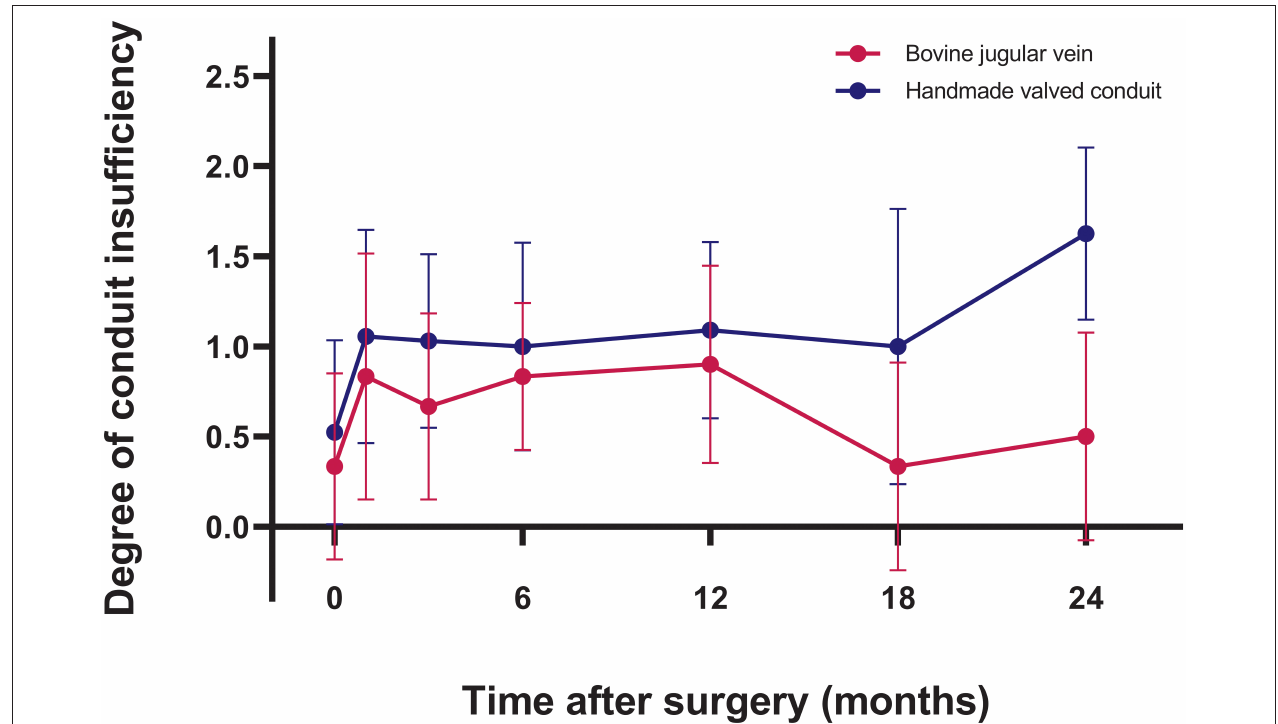
FIGURE 4 | Graphic showing postoperative trend of degree of conduit insufficiency in two types of conduits.